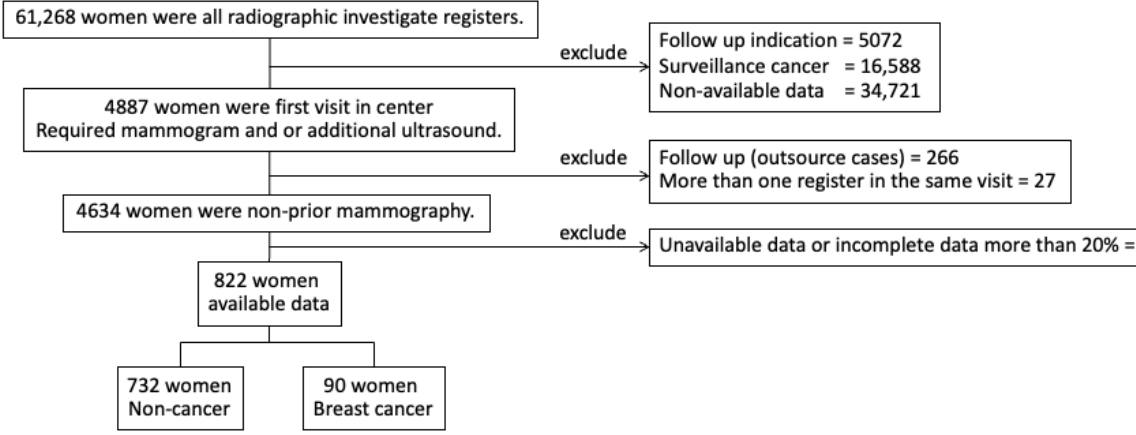
Figure 1. Participant